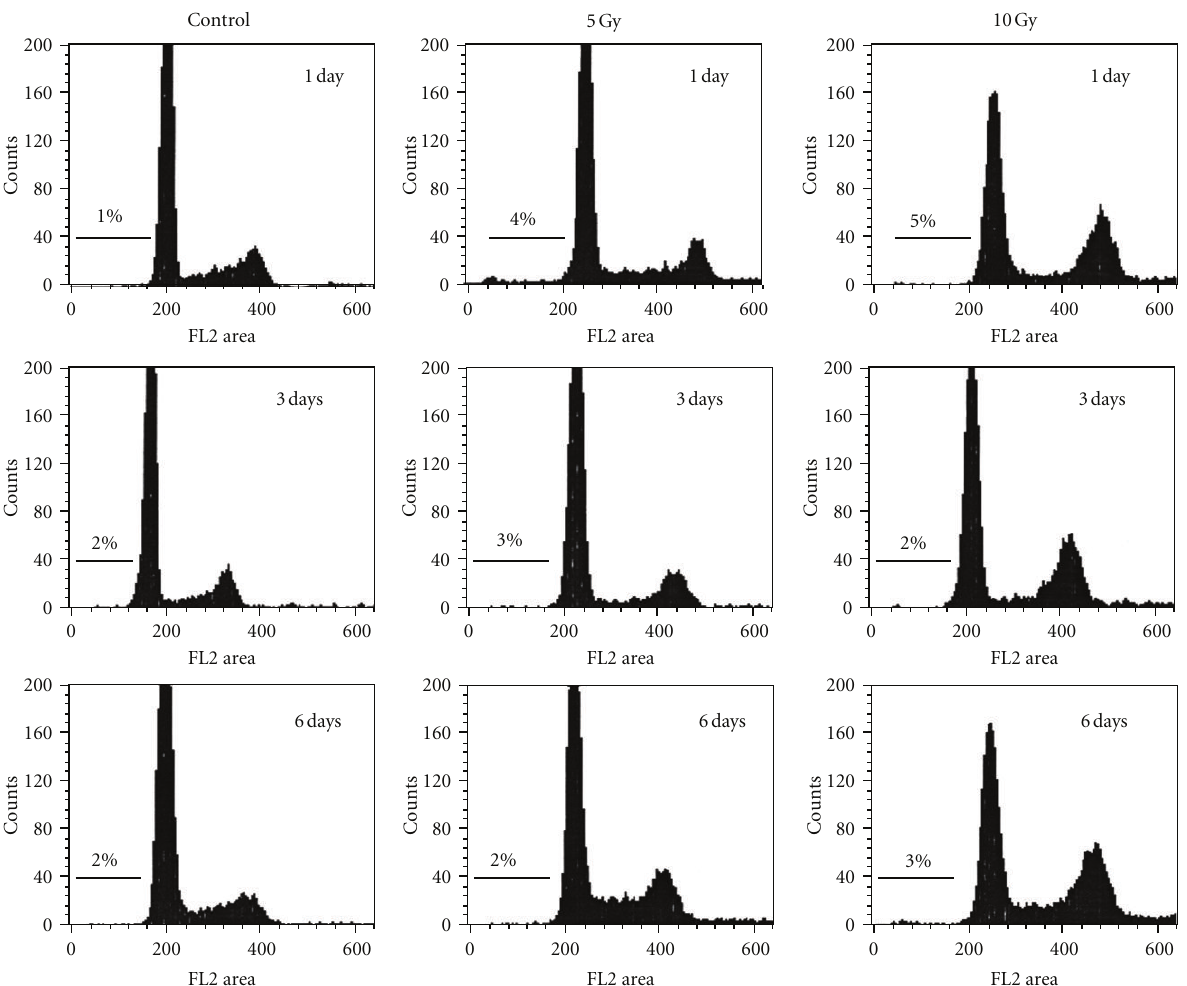
Figure 3: Flow cytometric profiles of A172 cell populations before (control) and after exposure to 5Gy or 10Gy doses of γ radiation and incubation for the indicated times. For each sample, the adherent and floating cells were combined and analyzed as described [33]. Relative cell number is plotted as a function of fluorescence intensity. The percentage of cells with sub-G1 (apoptotic) nuclei is indicated above the marked area in each